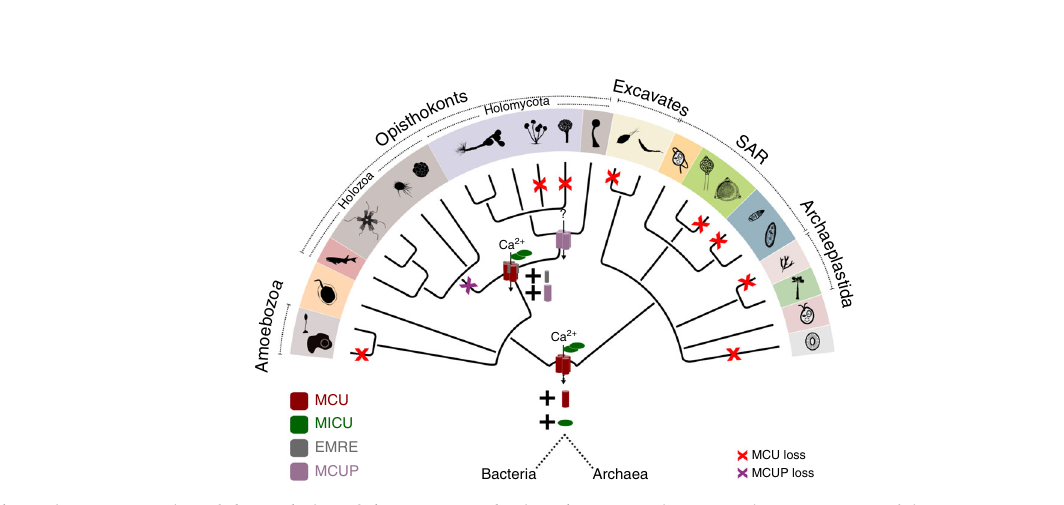
Fig. 4 Evolution of MCU – EMRE interaction. a , b Phylogenetic trees of members of MCU ( a ) and EMRE ( b ) protein families, and sequence diversity of major domains. The sequence alignment of TM1 and TM2 of MCU sequences from 20 species is shown in a . The program Multi-Harmony 43 was used to detect residues that are overall conserved but differ in the MCUP members (highest scoring positions are indicated with red arrows). The MCUP clade is shown in purple. The evolutionary point where the MCU proteins become EMRE dependent is shown in gray. The degree of conservation across the animal-related MCU members is very high in these loci, while few positions are Holomycota or Holozoa speci fi c. Similarly, in b EMRE ’ s sequence diversity across opisthokonts is shown for the β -hairpin, the TM, and CAD domain. Residues found important for the interaction between MCU and EMRE in ref. 20 and fully conserved positions are indicated with gray and red arrows, respectively. c – f Representative traces and quanti fi cation of mt-Ca 2 + transients in yeast cells expressing either human and animal-like S. punctatus and A. macrogynus MCU with human EMRE ( n = 3) ( c ), species-speci fi c EMRE with human MCU ( n = 3) ( d ), animal-like S. punctatus and A. macrogynus MCU with their respective wild type or truncated (-t) EMREs ( n = 4) ( e ) or with human EMRE fused to the chytrid extra C-terminal domain ( n = 4) ( f ) upon glucose-induced calcium (GIC) stimulation in the presence of 1 mM CaCl 2 . All data represent mean ± SEM. P values are indicated in the different panels ( c , e , f *** p < 0.001, one-way ANOVA with Dunnett ’ s multiple comparisons test; d * p = 0.012, one-way ANOVA with Dunnett ’ s multiple comparisons test). Source data for c – f are provided as a Source Data fi le.